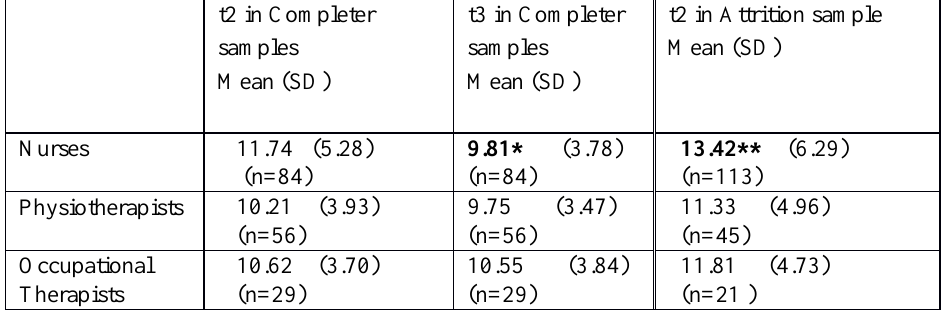
Comparisons of GHQ-12 Likert-scores for Completer Samples at t2 and t3 and for the t2 Scores for the Completer samples and the Attrition Samples t2 in